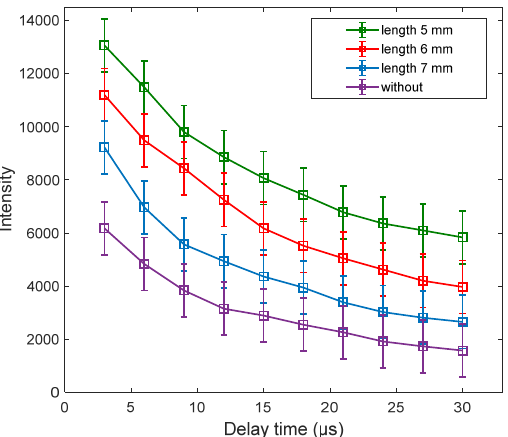
Figure 12. Time-resolved emission intensities of the Ti II–318.2 nm spectral lines for different sizes of the square cavity at laser fluence of 18.1 J cm − 2 .